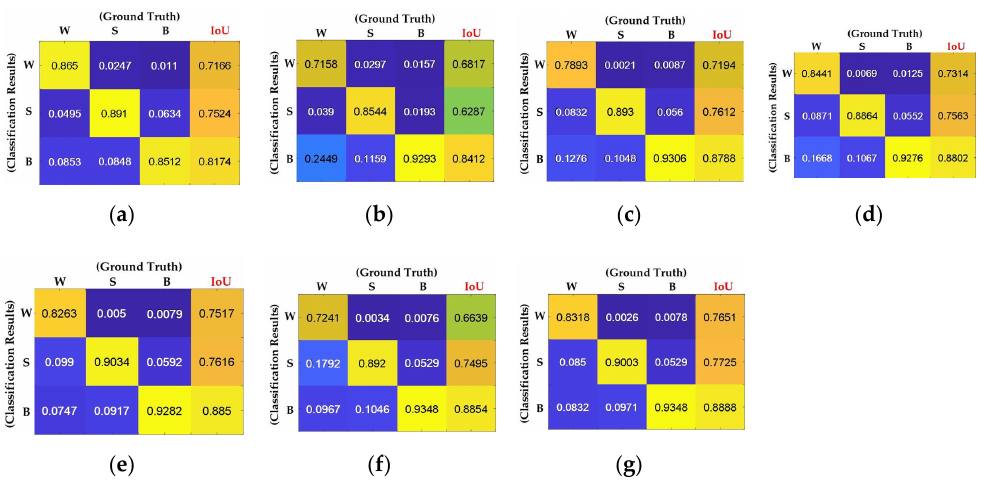
Figure 13. The classification accuracy and IoU of different methods. ( a ) RefineNet. ( b ) DeepLabV3. ( c ) MLSAN. ( d ) GLGCM-MLSAN. ( e ) Gabor-MLSAN. ( f ) MSOGDF-MLSAN. ( g ) MSF-MLSAN. (W, S and B denote Water, Shadow and Background, respectively).